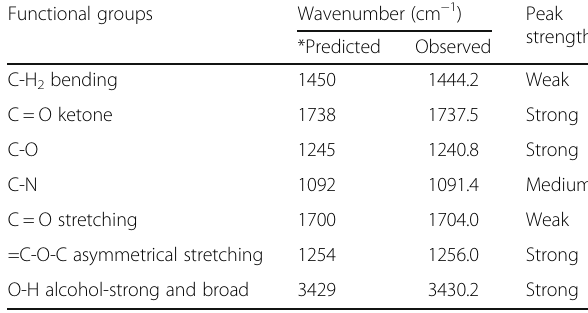
Table 5 Functional groups from the